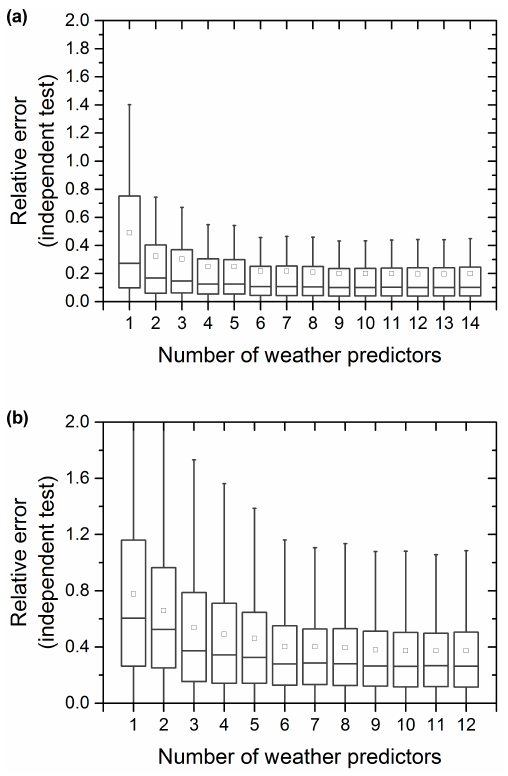
Figure 5. Relative error of the models fitted as a result of the fea- ture selection approach. Median (interior horizontal line), mean (in- terior square), 1 and 99% quantiles (edge of boxes), and range (ex- tremes). Relative errors were calculated for the prediction of 1974 and 1576 independent observations for spring (a) and autumn (b) , respectively. See previous figure for the weather predictor variables in the models, as shown on the x